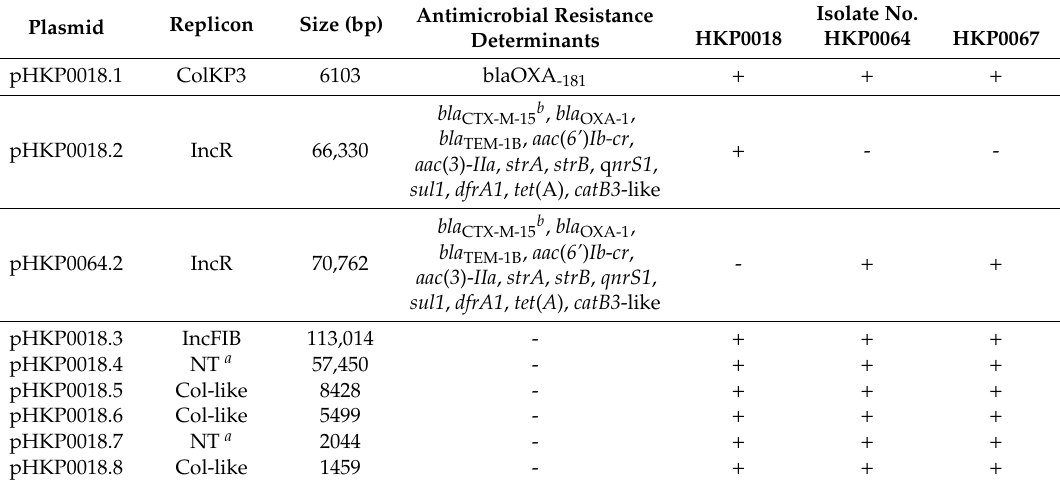
Table 1. Plasmid encoded antimicrobial resistance determinants, plasmid content and plasmid size of the isolates. Plasmid Replicon Size (bp)